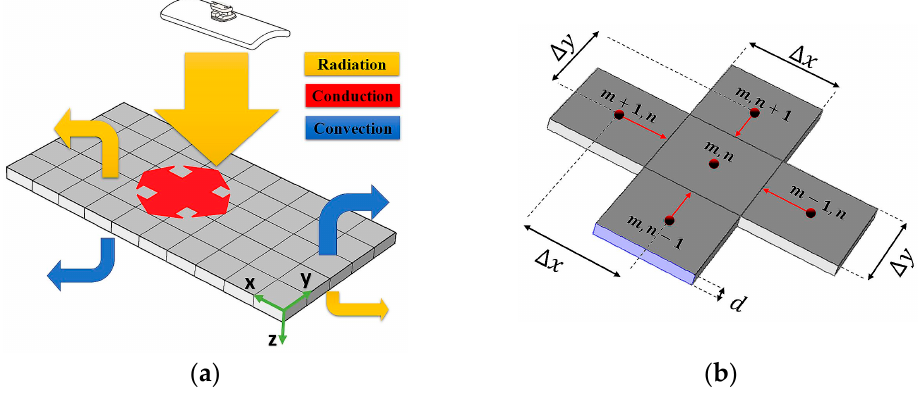
Figure 3. ( a ) Heat transfer between thermoplastic sheet, radiant heaters, and ambient; ( b ) elements for model.